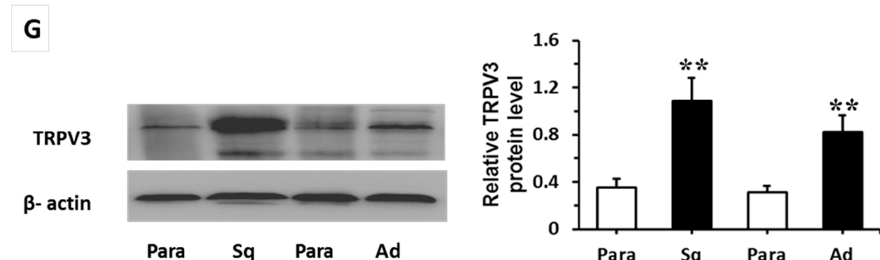
Figure 1. Expression of TRPV3 in human NSCLCS. Immunohistochemical staining of TRPV3 was examined in cancerous tissues and their corresponding paracancerous tissues. Brown grains represented positive signals. The positive expression site of TRPV3 was mainly localized in the cell membrane and cytoplasm of tumor cells. TRPV3 negative expression was in paracancerous tissue (Para) ( A , B ), and TRPV3 positive expression was in lung squamous cell carcinoma (Sq) ( C , D ) and lung adenocarcinoma (Ad) ( E , F ). ( A , C , E ) 200×; and ( B , D , F ) 400×. The expression of TRPV3 in lung Ad, lung Sq, and Para ( G ) was determined by Western blot. Each bar represents the mean ± SD of three independent experiments. ** p < 0.01 compared with paracancerous tissue. Table 1. Association of TRPV3 expression in NSCLC with clinical and pathologic factors.